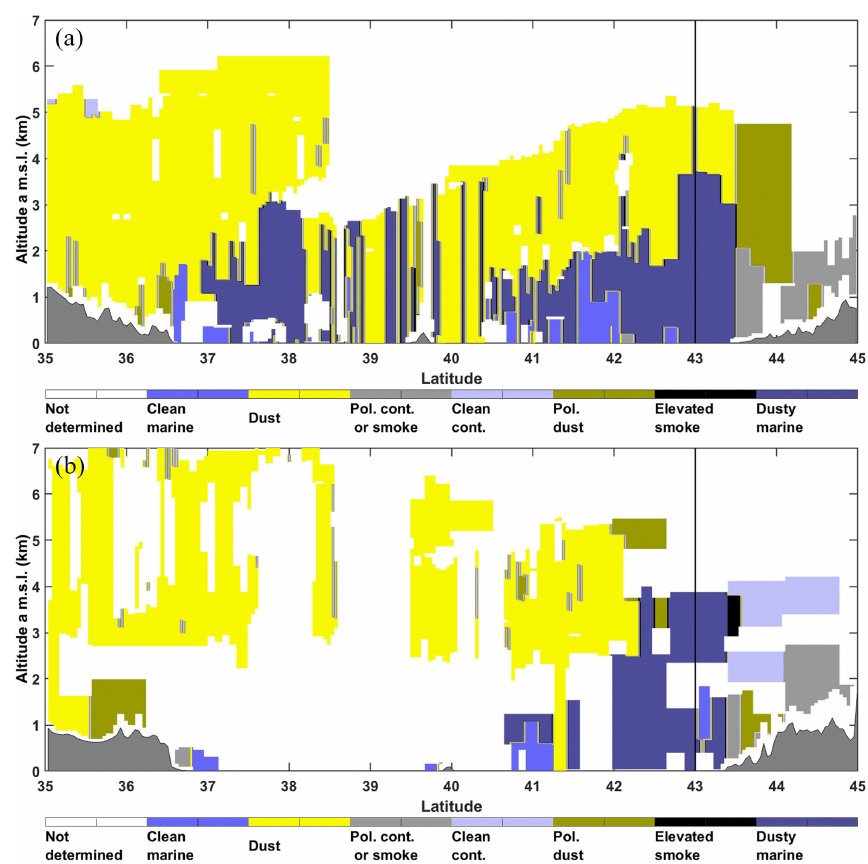
Figure 15. CALIOP-derived aerosol typing (version 4.10) for the nighttime orbit of (a) 24 June 2014 and (b) 3 July 2014. The latitudinal location of the nearest latitude of the ground-based lidar is indicated by the vertical black